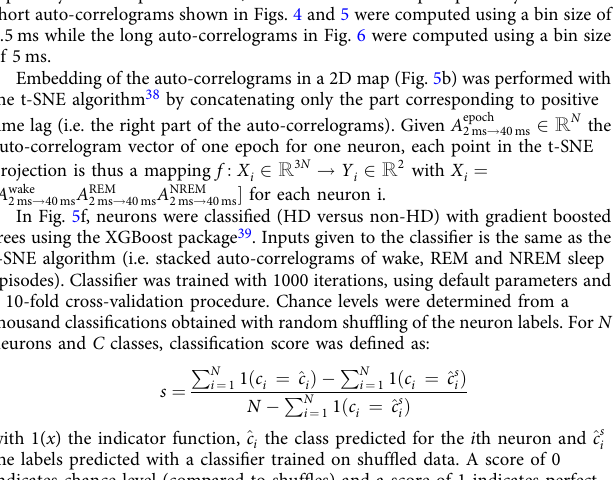
(Figs. 4e – g), auto-correlograms were fi rst stacked across brain states (as done for the t-SNE projection, see above). We used PCA to reduce the dimensionality of each matrix (of either SWRs cross-correlograms or stacked auto-correlograms) and we kept the fi rst 10 components accounting for respectively 91% and 99% of the variance. We computed the 20-by-20 correlation matrix C for the 10 SWR PCs and 10 auto-correlogram PCs. The matrix is diagonal for the upper-left and bottom right 10-by-10 blocks as PCs from a given dataset are perpendicular to each other. We thus show only the off-diagonal matrix in Fig. 4f. We then SWR cross-correlograms, then total correlation would be the linear correlation between the two PCs). From a geometrical perspective, this measure captures